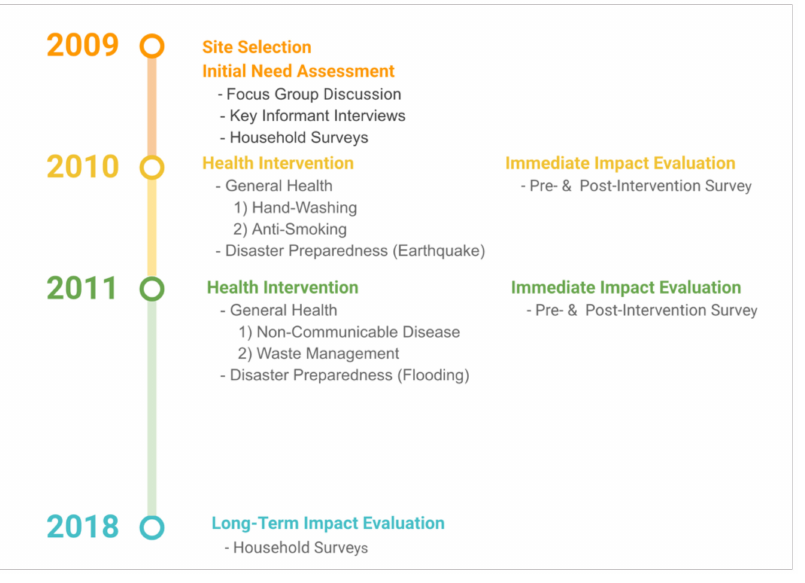
Figure 1. Project Timeline and Outline for the Ma’an Qiao Village